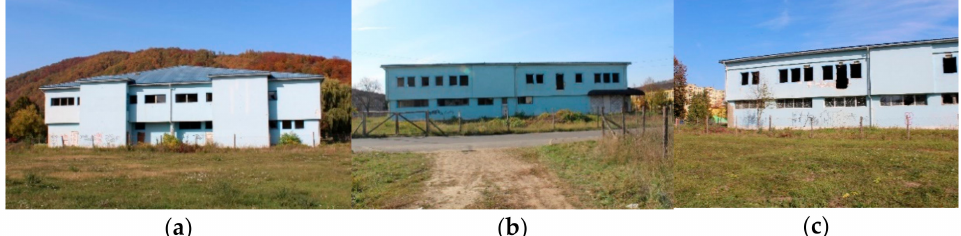
Figure 2. Building of the shopping center in Snina: ( a ) Southern view; ( b ) Eastern view; and ( c ) Northern